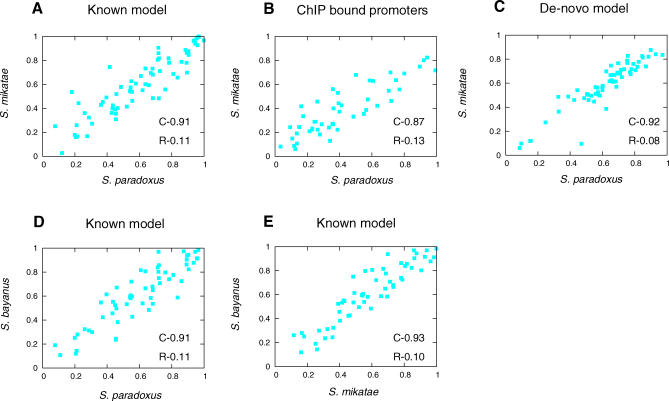
Selection FactorsShown are inferred selection factors, compared for pairs of similar target k-mer sets on alignment of S. cerevisiae promoters with different yeast species. C, the correlation between the σ values in the two models. R, the root mean square difference value. The high correlation among the inferred σ values indicates that our model successfully decomposes the background mutation rate (which is different for each species) and the selection on each TFBS (which is quite stable as seen here).(A,D,E) Comparison of σ values in the literature-based model for each pair of species.(B) The literature-based model using ChIP-bound promoters only on cerevisiae-paradoxus alignments compared to the same model on cerevisiae-mikatae alignments.(C) The de novo model on cerevisiae-paradoxus alignments compared to the same model on cerevisiae-mikatae alignments.